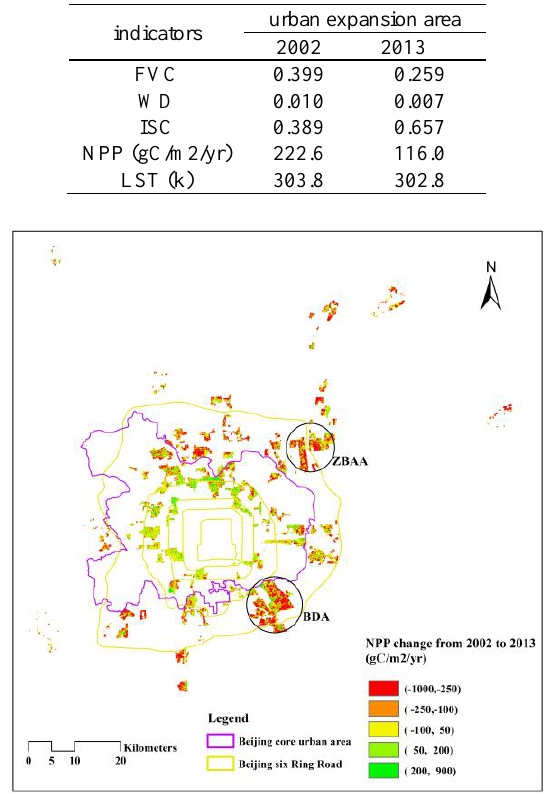
Figure 2. NPP Change map in Beijing urban sprawl areas